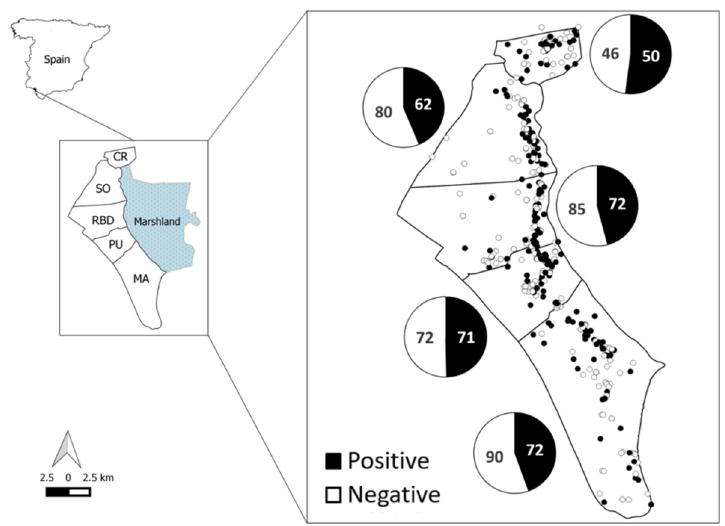
Figure 1. Map of the study area, Doñana National Park. The livestock management areas (Coto del Rey (CR), Sotos (SO), Doñana Biological Reserve (RBD), Puntal (PU) and Marismillas (MA)) are delimited. Sampling distribution and the number of animals positive and negative for HEV-antibodies observed in each livestock management area are also shown. Black and white symbols mean animals positive and negative for anti-HEV antibodies, respectively. The ecotone is the north to south line between the marshland (east, in blue) and the management areas (west).